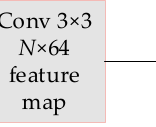
Figure 7. Decoding structure.